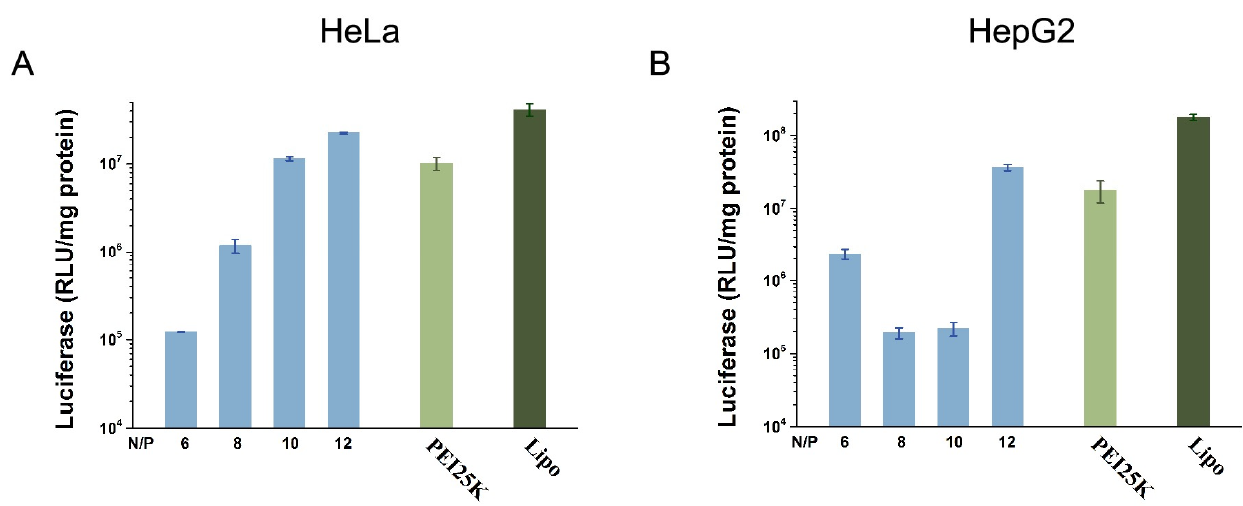
Figure 7. Luciferase expression induced by QM-SS-KK/DOPE of various N/P ratios in HeLa cells ( A ) and HepG2 cells ( B ) with the supplement of 10% FBS. PEI25K (N/P = 10) and lipofectamine 2000 were taken as controls. Data represent mean ± SD ( n = 3).